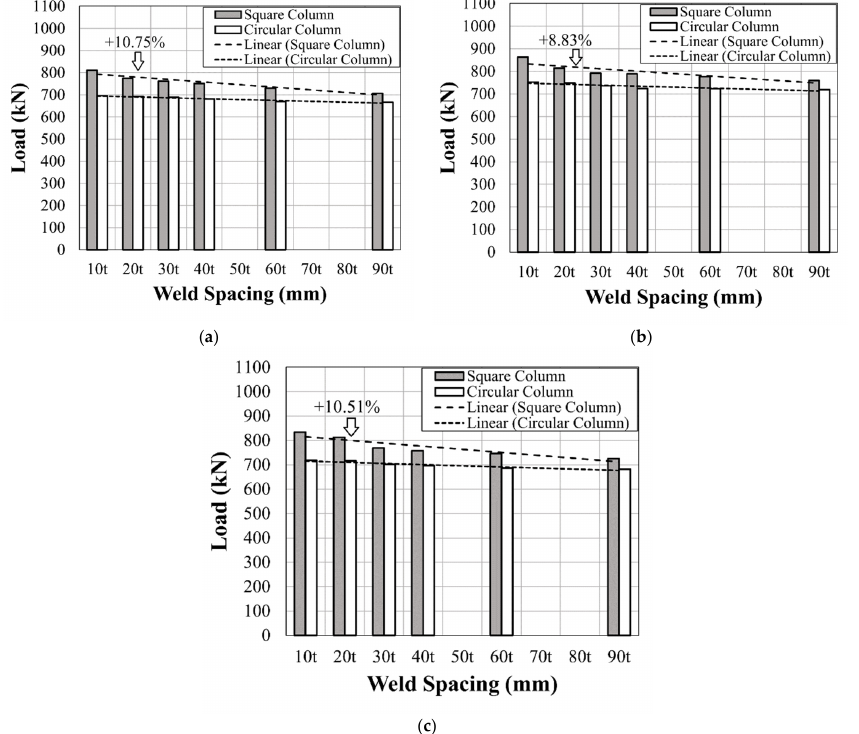
Figure 22. Comparison of the shape of the CFDST column with t s = 2.8 mm on the axial load